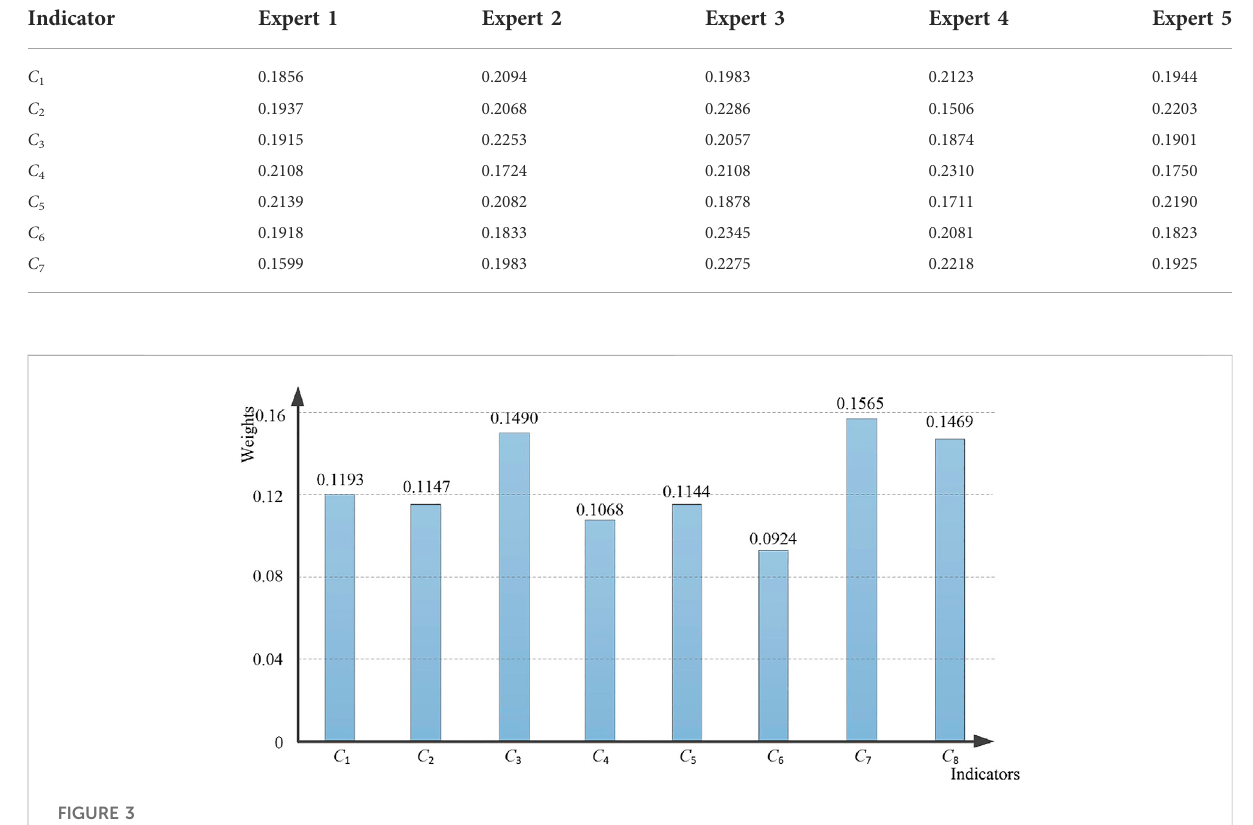
FIGURE 3 Weights of every one-level